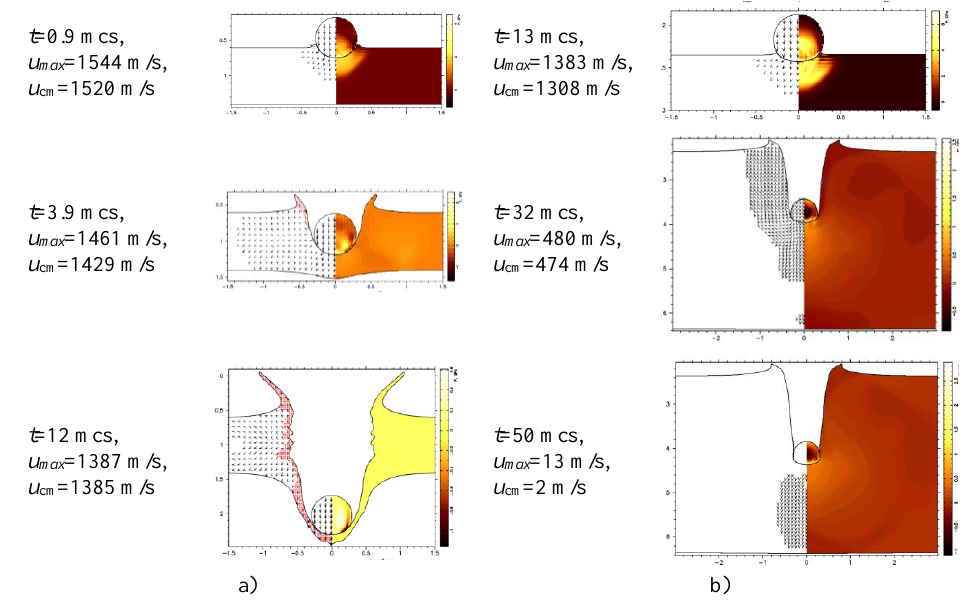
Fig 5. The chronogram of the interaction process between the drummer and the barrier made from PMMA ( a ), and with the barrier-“witness” ( b ) at V 0 = 1595